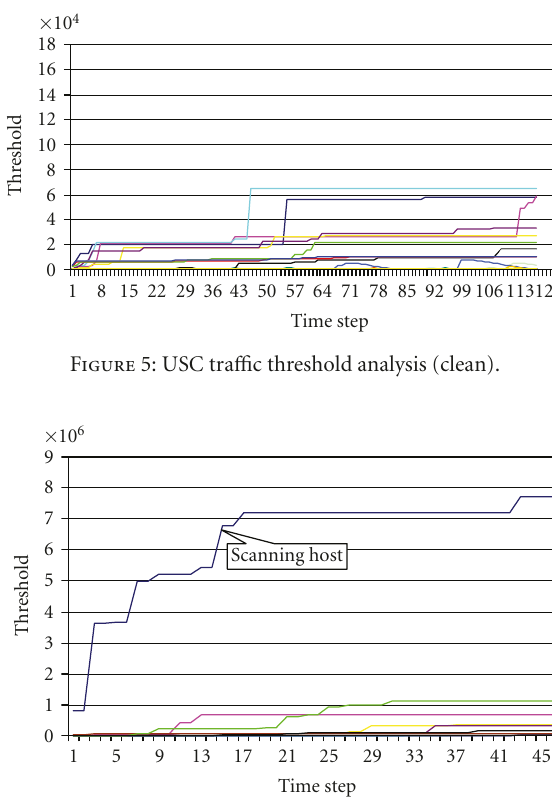
Figure 6: USC tra ffi c threshold analysis (half-open scan).